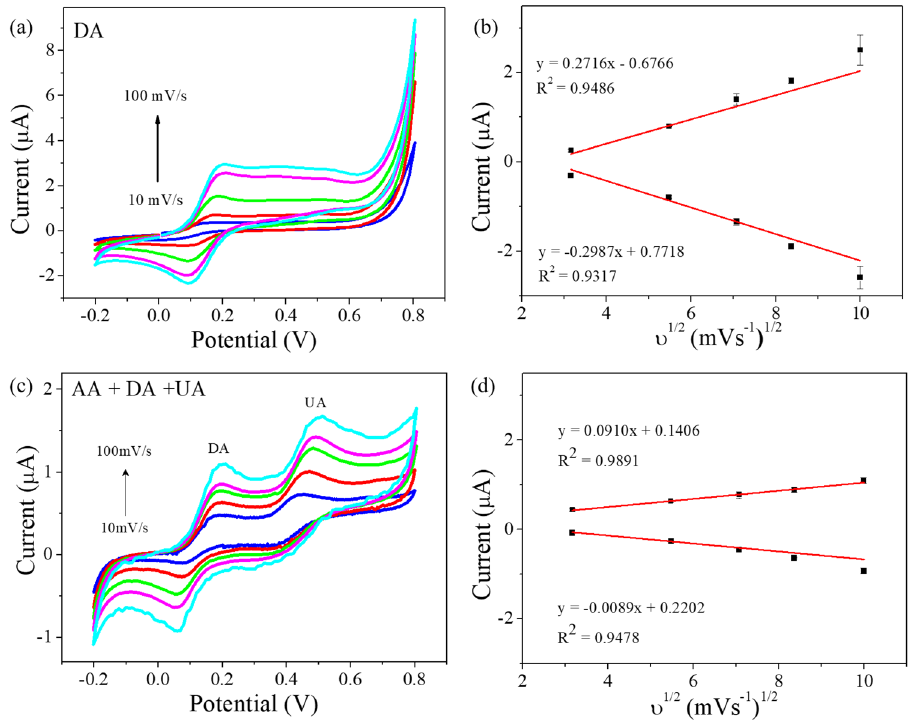
Figure 4. ( a ) Cyclic voltammograms of the sensor with GO/PEDOT:PSS composite to 1 mM DA concentration by various scan rates (10–100 mVs −1 ); ( b ) Linear fitting of the oxidation peak currents to the various scanning rates (n = 3); ( c ) cyclic voltammograms of the sensor with GO/PEDOT:PSS composite to the 1 mM AA, 5 μM DA, and 50 μM UA by various scan rates (10–100 mVs −1 ); ( d ) Linear fitting of the peak oxidation currents to 5 μM DA (n =